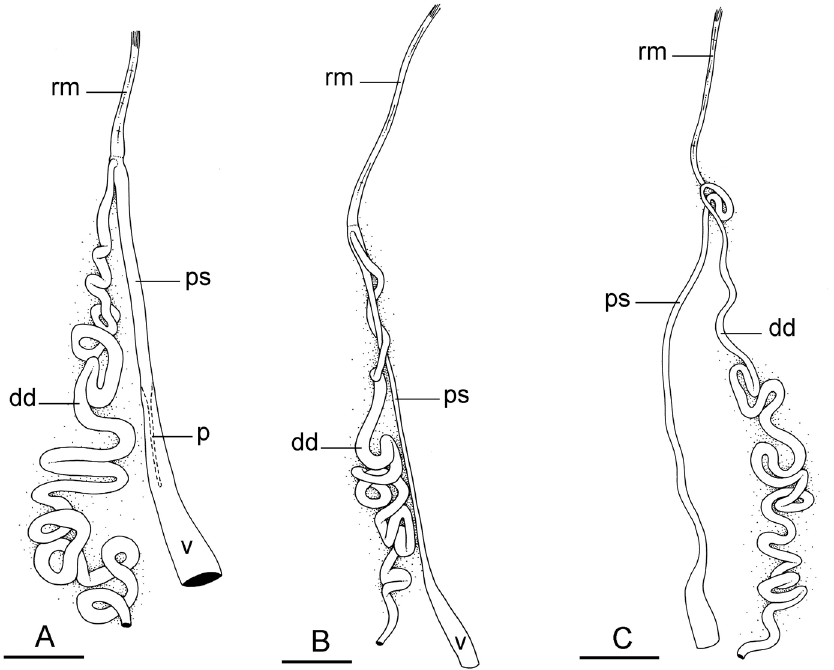
Figure 64. Reproductive system, anterior, male copulatory parts, Wallaconchis melanesiensis . A Vanua- tu, scale bar 1 mm [5484] (IM-2013-62406) B Indonesia, Halmahera, scale bar 2 mm [5132] (UMIZ